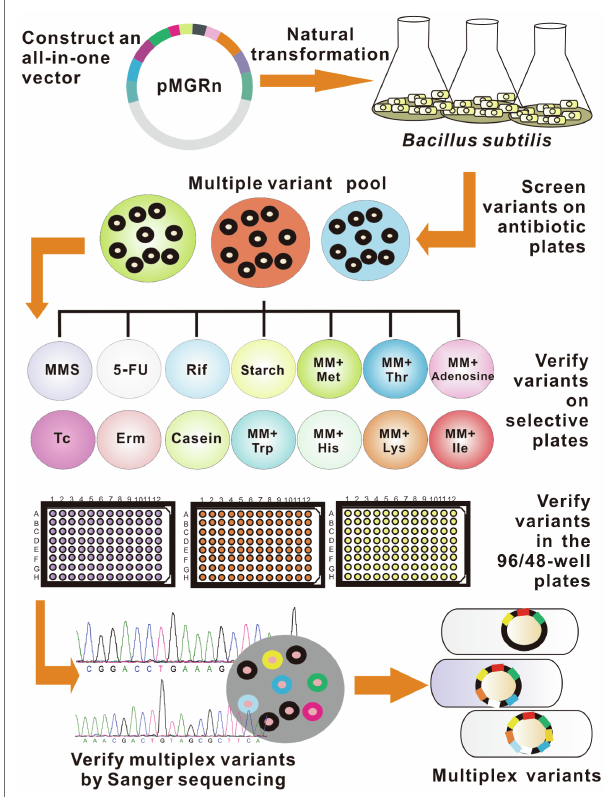
FIGURE 2 | Detailed schematic showing SMGE. All variants were first screened in the Luria-Bertani (LB) plate containing antibiotics and then identified in the LB agar plates and 96-well/48-well plates containing selective media. Rif, Erm, Tc, and MMS represent LB plates containing rifampicin, erythromycin, tetracycline, and methyl methanesulfonate, respectively. 5-FU, starch, and casein represent LB media supplemented with 5-fluorouracil, starch, and casein, respectively. MM-Met, MM-Thr, MM-Ade, MM-Trp, MM- His, MM-Lys, and MM-Ile represent minimal media (MM) supplemented with methionine, threonine, adenosine, tryptophan, histidine, lysine, and isoleucine,